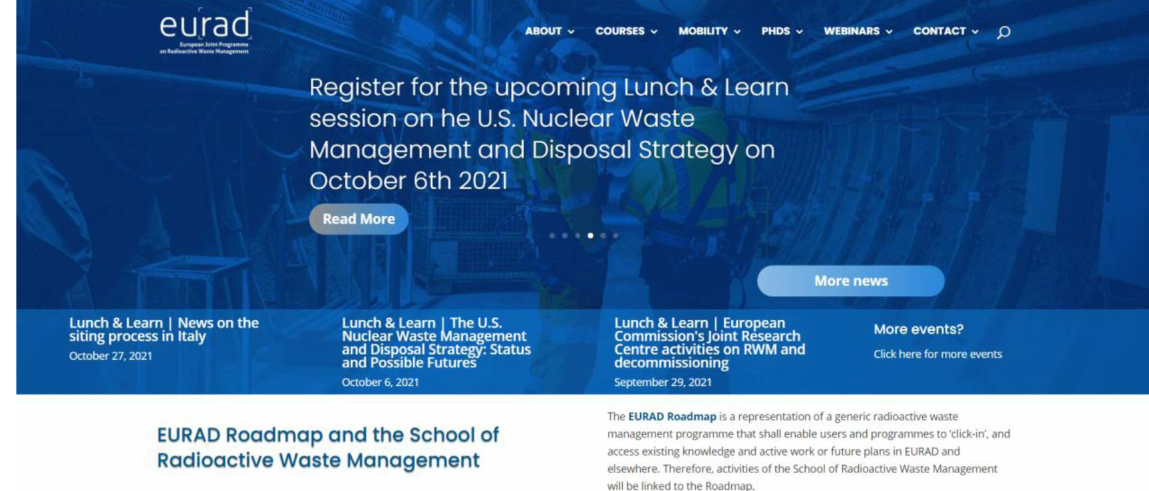
Fig. 1. Home page of the School of Radioactive Waste Management’s webpage ( https://euradschool.eu/ ). The home page allows navigating between information on courses, mobility, Ph.D. students, webinars, and general information on the School of RWM. Additionally, it allows access to the discussion forum and a list of publications by the EURAD Training and Mobility work